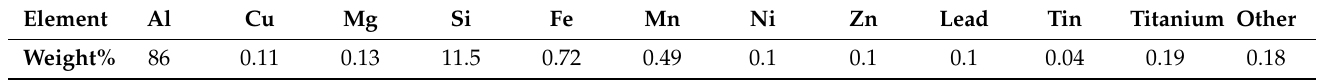
Table 1. Compositional variation of LM6